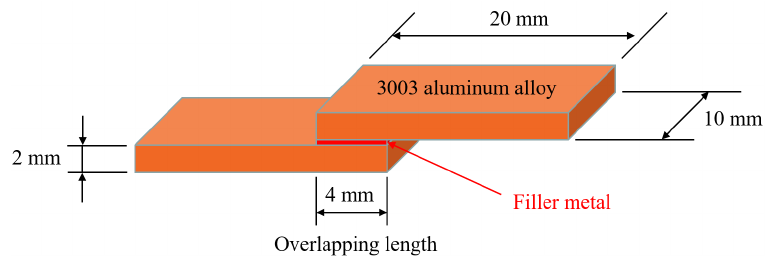
Figure 2. Schematic illustration of brazed specimens.